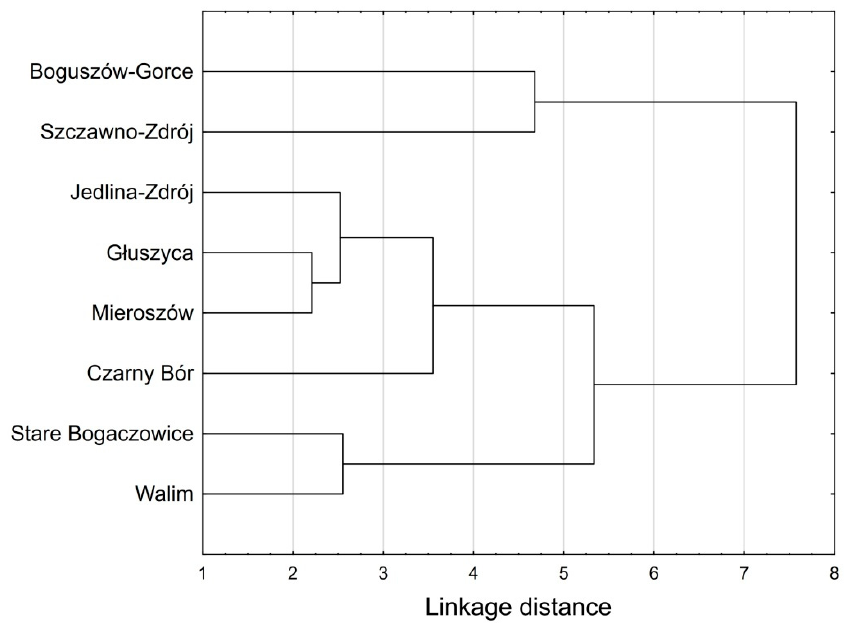
Figure 6. Tree diagram of environmental potential 2016–2018. Source: authors’ compilation based on bdl.stat.gov.pl (accessed on 30 October 2020) [32].